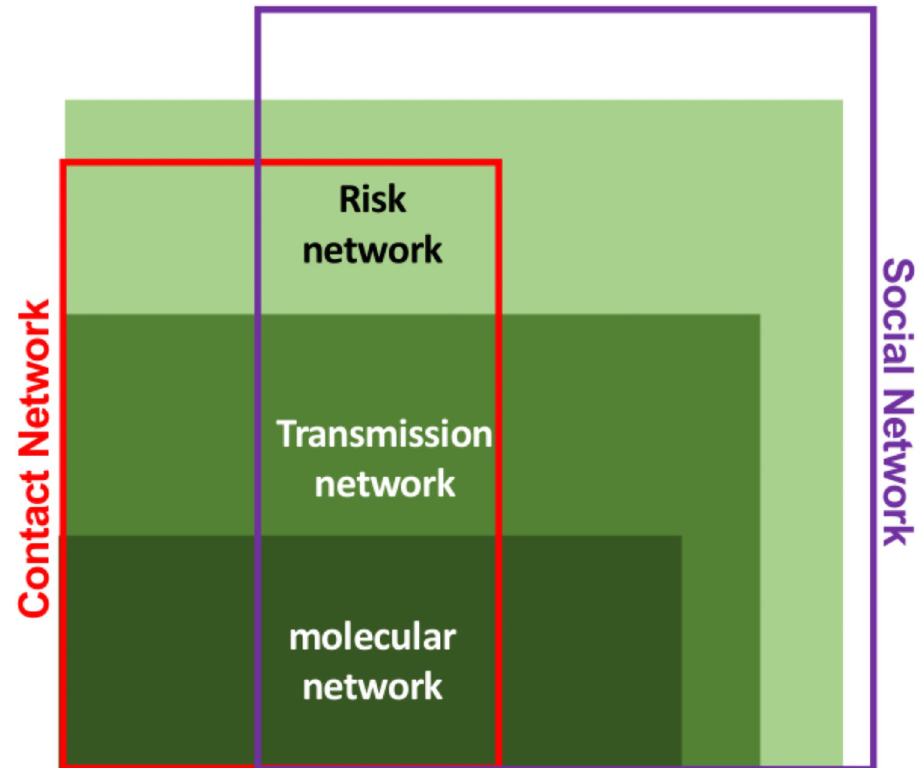
Fig 2. Relationship of the active elements in progressing HIV